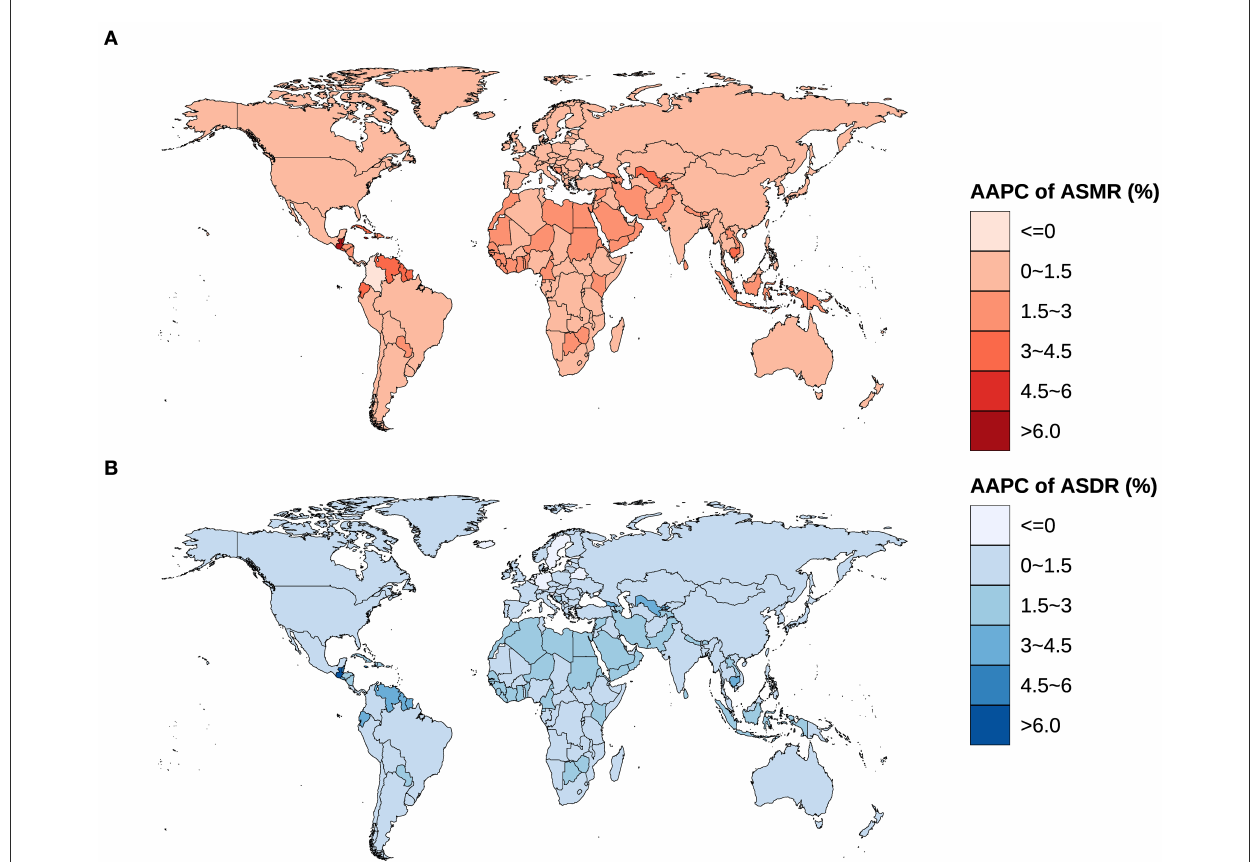
FIGURE3 Global spatial distribution of AAPCs on ASMR and ASDR of ovarian cancer attributable to hyperglycemia from 1990 to 2019. (A) AAPC of ASMR, (B) AAPC of